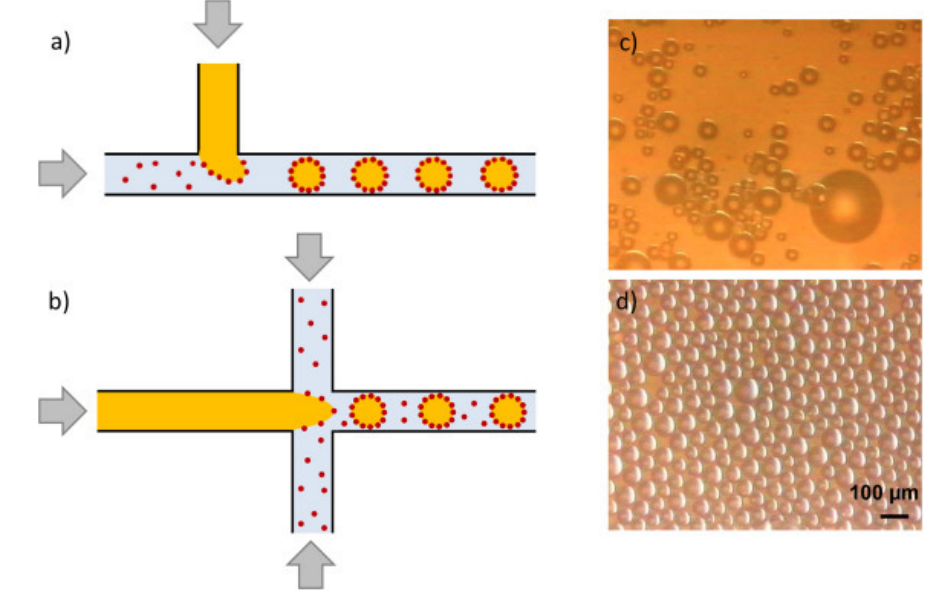
Figure 6. Microfluidic devices ( a ) T-junction and ( b ) flow-focusing for Pickering emulsions preparation. Light micrograph images of silica-stabilized emulsions by ( c ) a homogenizer and ( d ) a microchannel emulsification [8] .